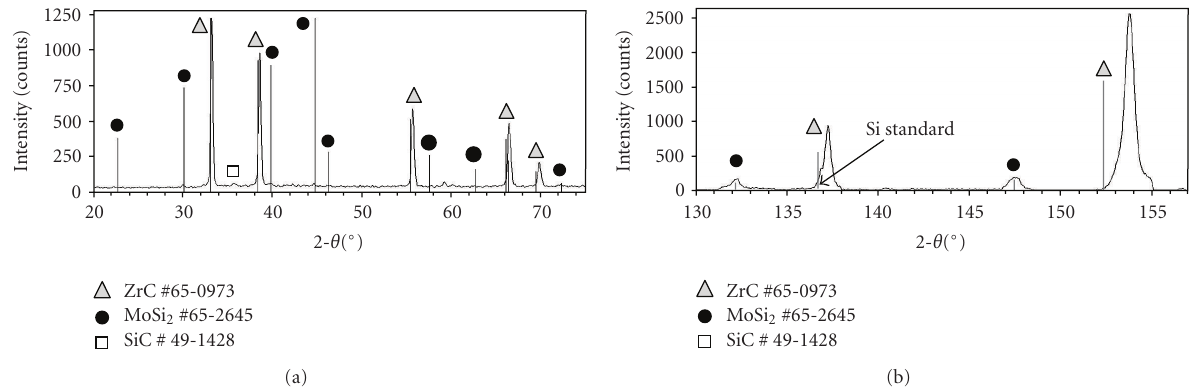
Figure 2: Comparison between experimental reflections and theoretical lines from PDF cards. The x-ray di ff raction was performed at (a) low 2-theta angles and (b) high 2-theta angles. Note in b) the signal of the Si-standard.